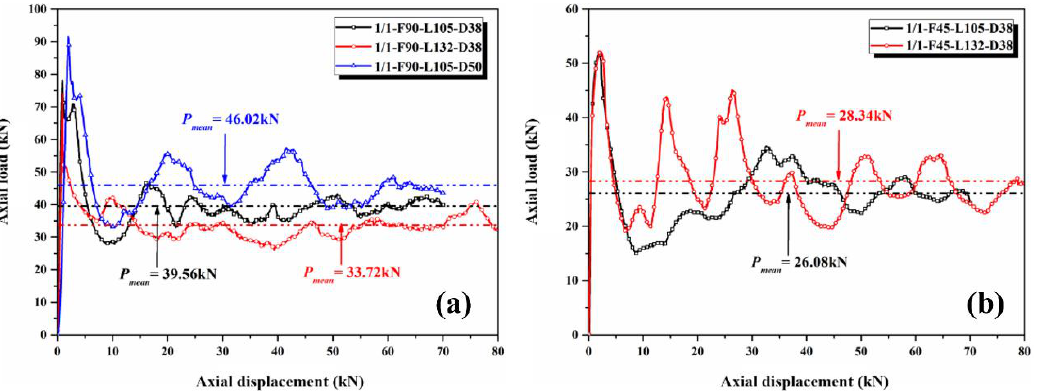
Figure 7. Load – displacement curves of 1/1 hybrid tubes with ( a ) [0°/90°] lay-up sequence and ( b ) [45°/ −4 5°] lay-up sequence.